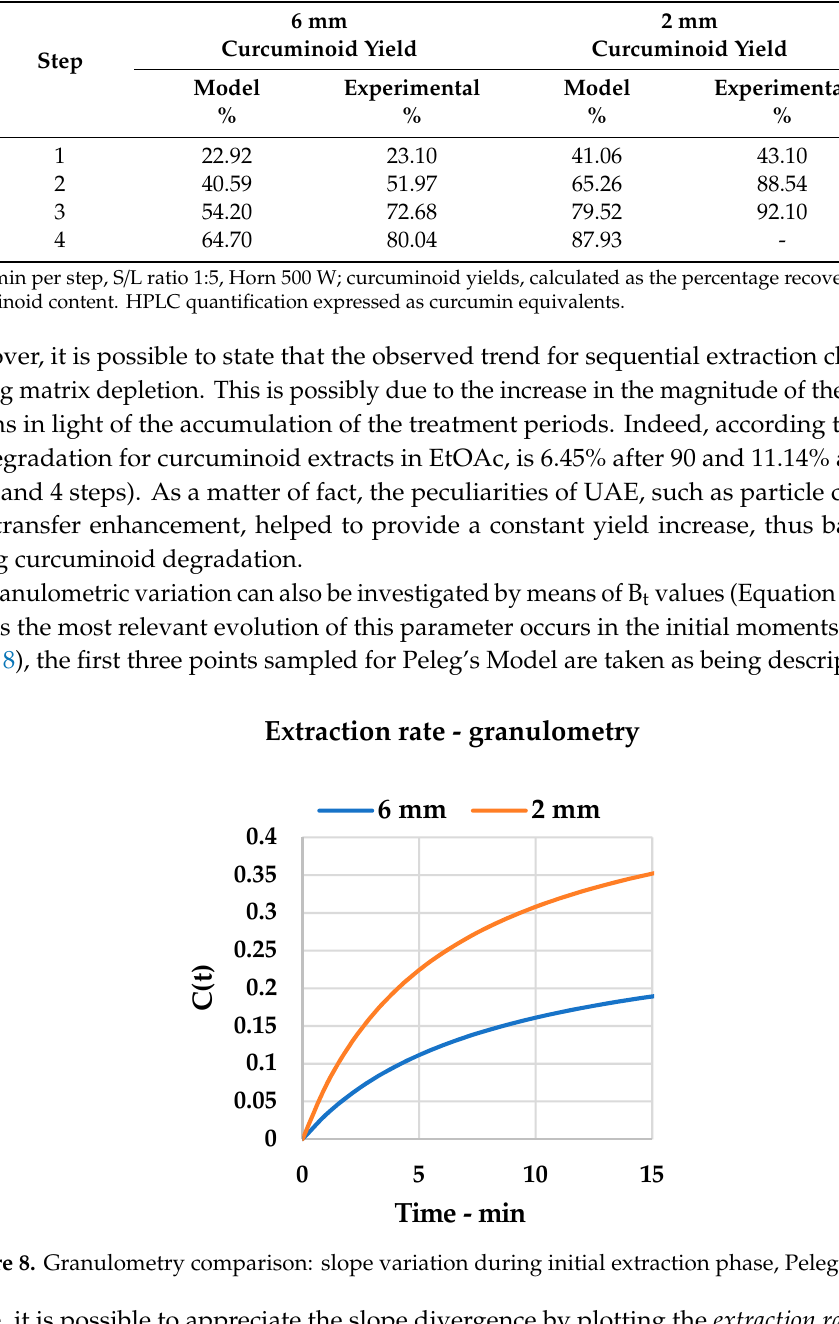
Figure 9. Extraction-rate variation with granulometry. B t of 2, 5 and 7.5 min compared to overall B 0 . 4.3. Crystallization The features and the advantages of using EtOAc as the extraction solvent were also investigated in terms of metabolite purification via crystallization. In addition to the better stability against curcuminoid radical degradation, the acetate showed an interesting predisposition to crystal generation, which was not observed in the EtOH extracts, under the tested conditions. The efficiency of this purification step is crucial if complex and expensive protocols, such as chromatography, are to be avoided. The final detected purity of the crystallized curcuminoids is 95% on average, as determined by HPLC and expressed as curcumin equivalents.